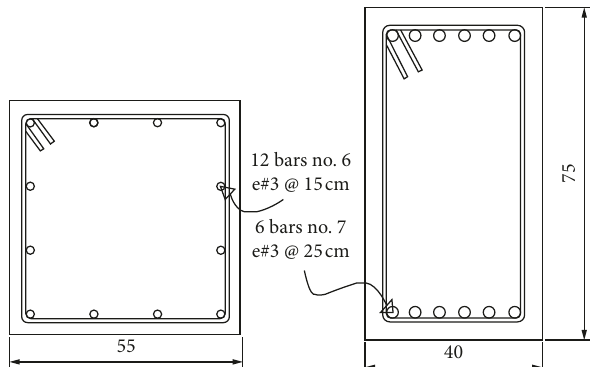
Figure 17: Optimal beam and column sections for levels 1–3 of individual 1, model RC-9.